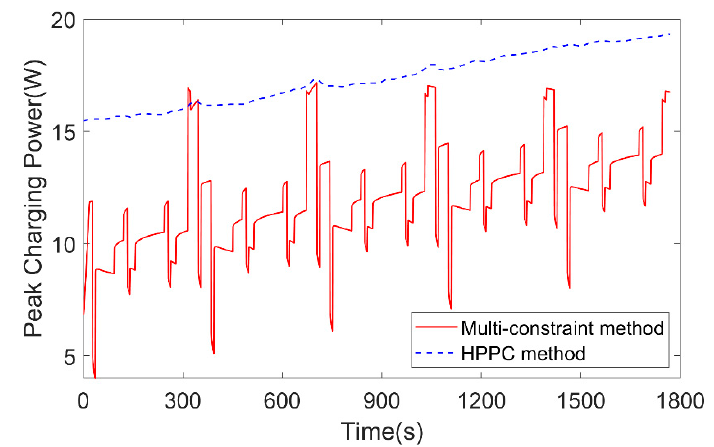
Figure 26. Charge peak power prediction curve.